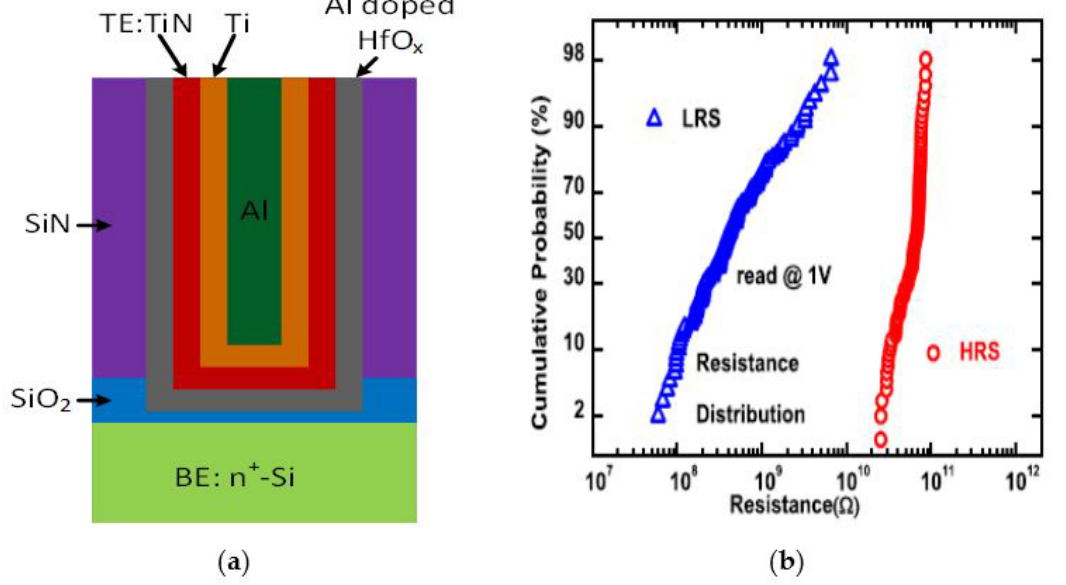
Figure 17. ( a ) A resistive RAM (RRAM) cell cross-section; ( b ) measured resistance distribution of R HRS and R LRS . Reproduced with permission from [49], Copyright IEEE,